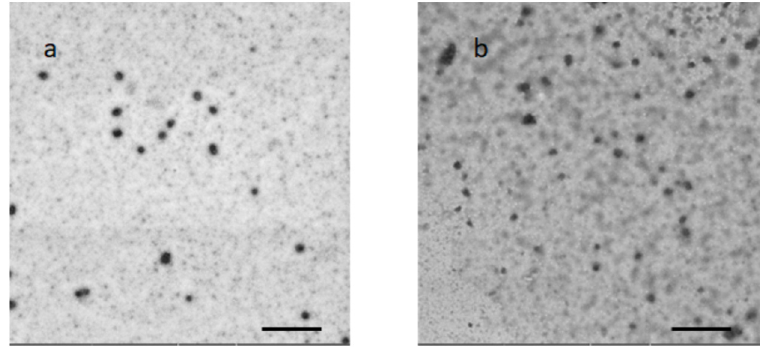
Figure 2. UA–PM ( a ) and UA–PML ( b ) TEM analysis Bar: 500 nm.